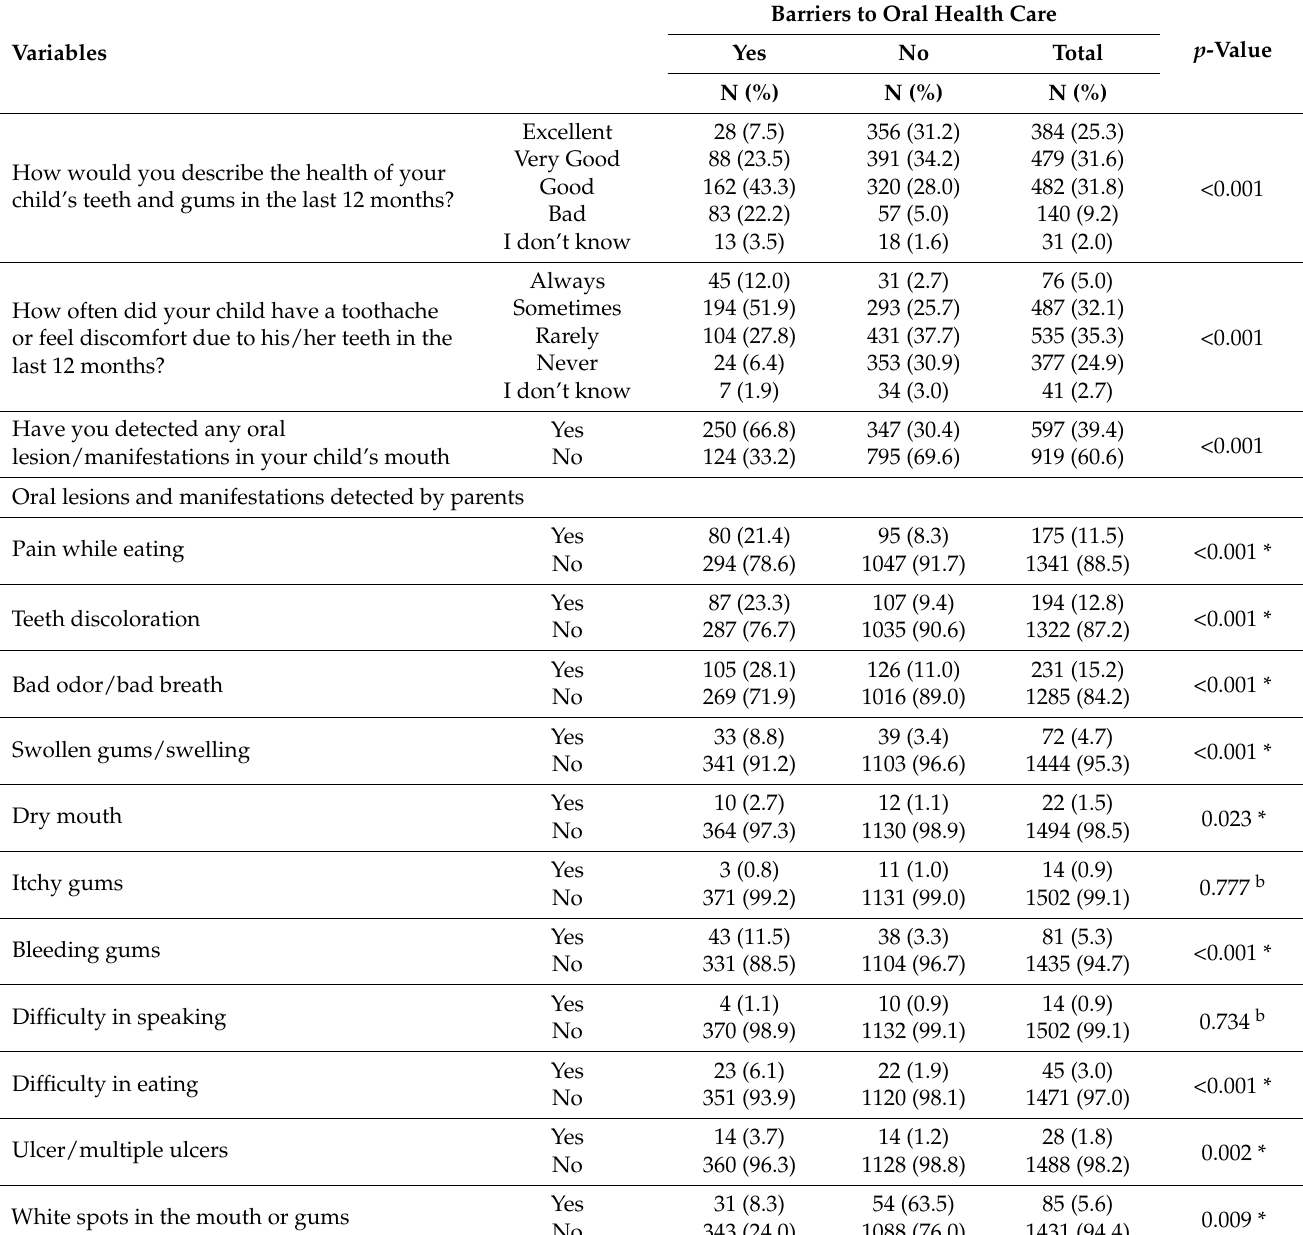
Table 2. Distribution of participants according to barriers to oral health care, parental description of their child’s oral health care needs, and oral manifestations (N =